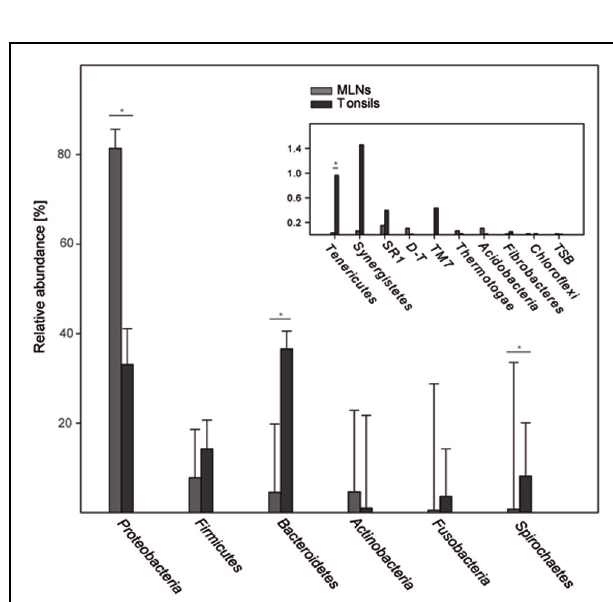
FIGURE 5 | Relative abundances of bacterial phyla. Abundant phyla with more than 2% mean abundance are shown for each sampling site (tonsils, MLNs = mandibular lymph nodes). In the inlay, relative abundances of rare phyla ( < 2% mean abundance) are depicted. The phylum Deinococcus–Thermus is abbreviated with D–T , Thermodesulfobacteria with TSB . Error bars represent standard error of the means. Significance in one sampling site compared to another is marked with an asterisk and is defined as p ≤ 0.05 and q ≤